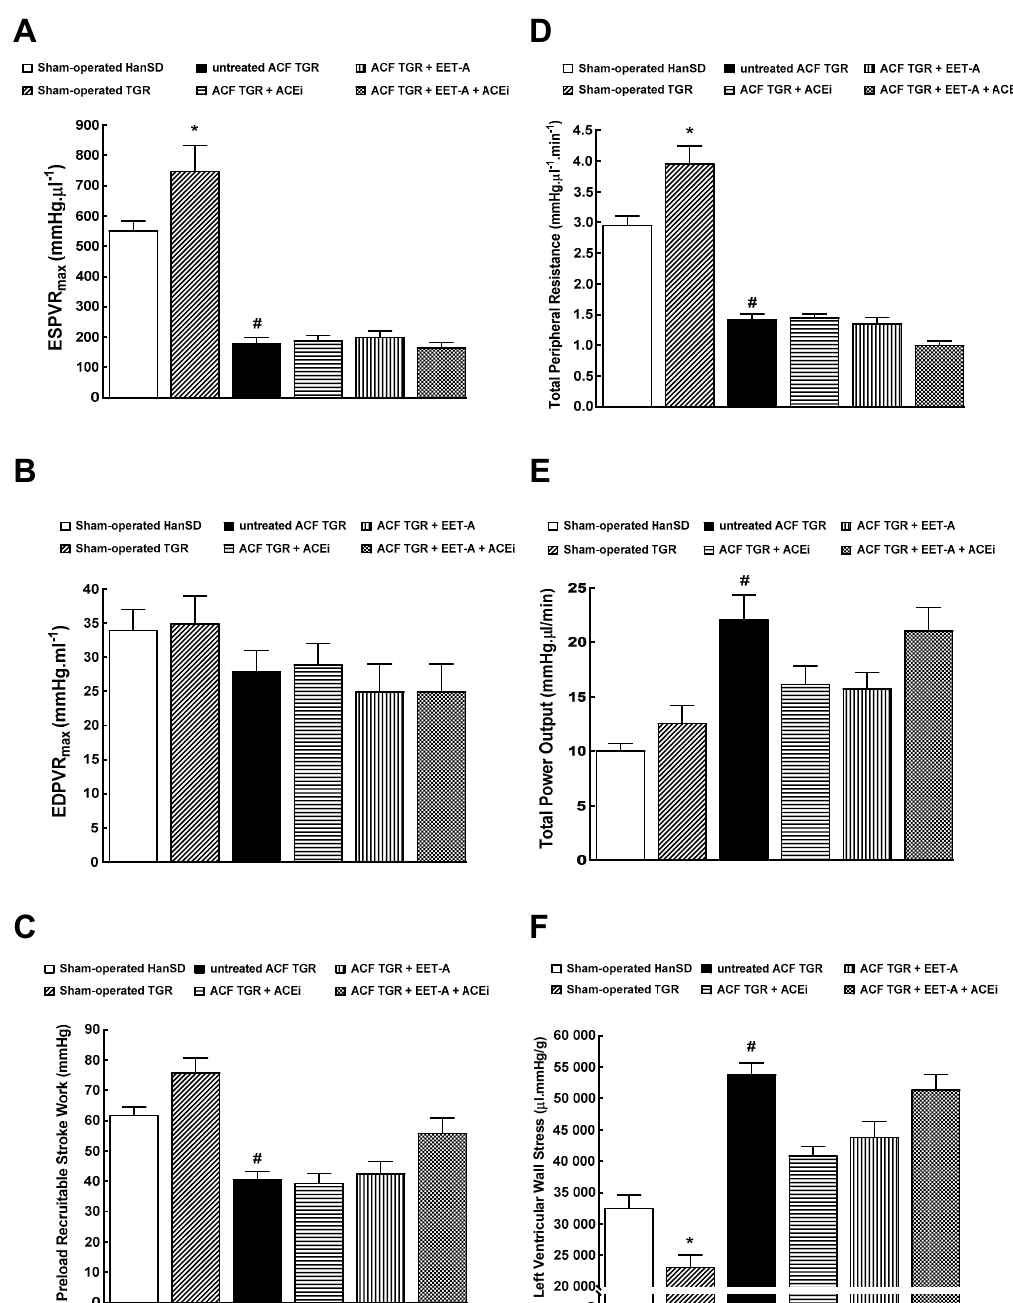
Figure 5. Part 2 of the left ventricular cardiac function assessment by invasive hemodynamic analysis performed 4 weeks after creation of the aorto-caval fistula (ACF) and 2 weeks after initiation of treatment in sham-operated transgene-negative Hannover Sprague-Dawley (HanSD), sham-operated heterozygous Ren-2 transgenic rats (TGR) and TGR rats with ACF, untreated or treated with angiotensin-converting enzyme inhibitor (ACEi) alone or with 14,15-epoxyeicosatrienoic acid analog (EET-A) alone or with combination of EET-A and ACEi. End-systolic pressure-volume relationship (ESPVR) ( A ), end-diastolic pressure-volume relationship (EDPVR) ( B ), preload recruitable stroke work ( C ), total peripheral resistance ( D ), total power output ( E ), left ventricular wall stress ( F ). * p < 0.05 for sham-operated TGR versus sham-operated HanSD rats. # p < 0.05 for untreated ACF TGR versus sham-operated TGR.